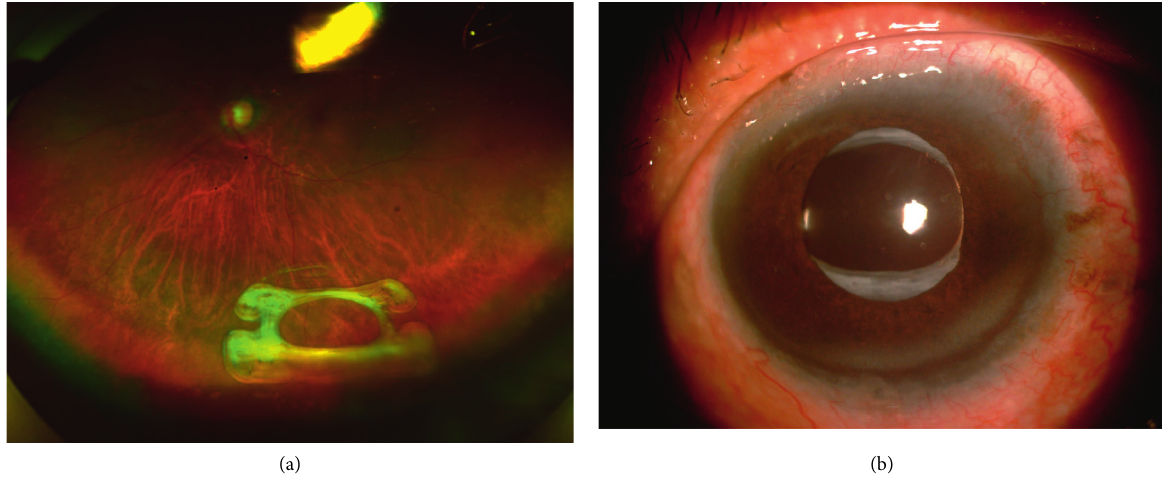
Figure 2: (a) Preoperative overview of a dislocated IOL-capsular bag complex (arrow) in the vitreous cavity. (b) Postoperative overview of the well-positioned four-point refixated IOL-capsular bag complex. No erosion or exposure of the trimmed ends of the sutures and no scaring of the conjunctiva were